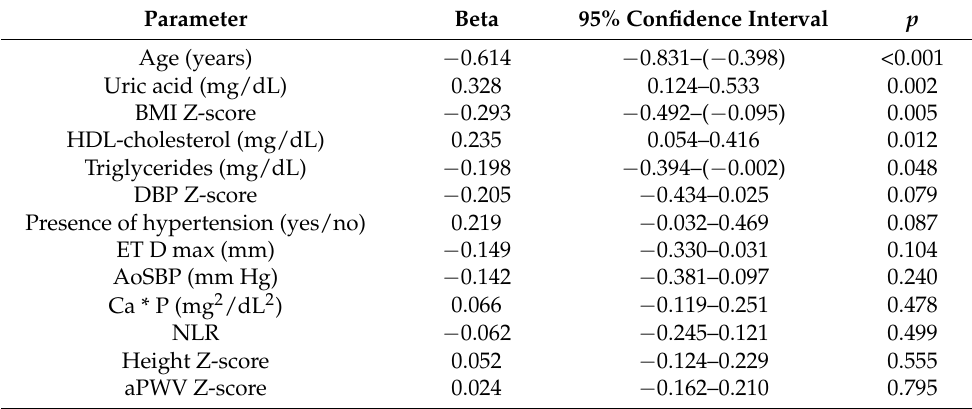
Table 5. Multivariate analysis of periostin determinants in